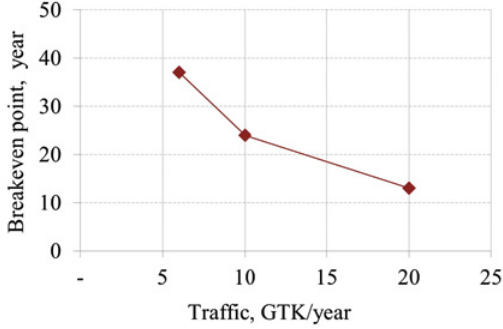
Figure 5. Breakeven point of total costs vs traffic